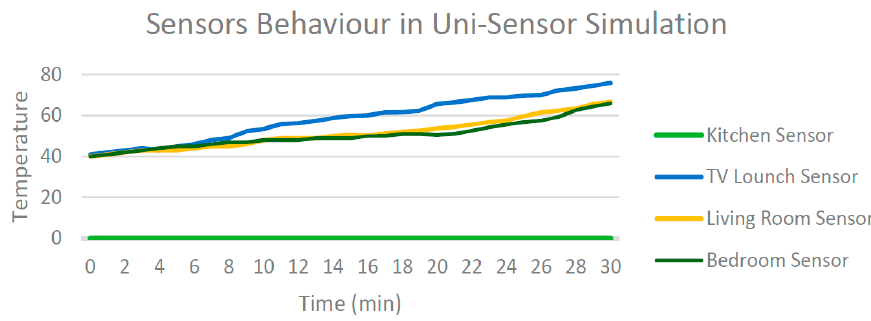
Figure 10. Sensor behavior in the uni-sensor simulation.